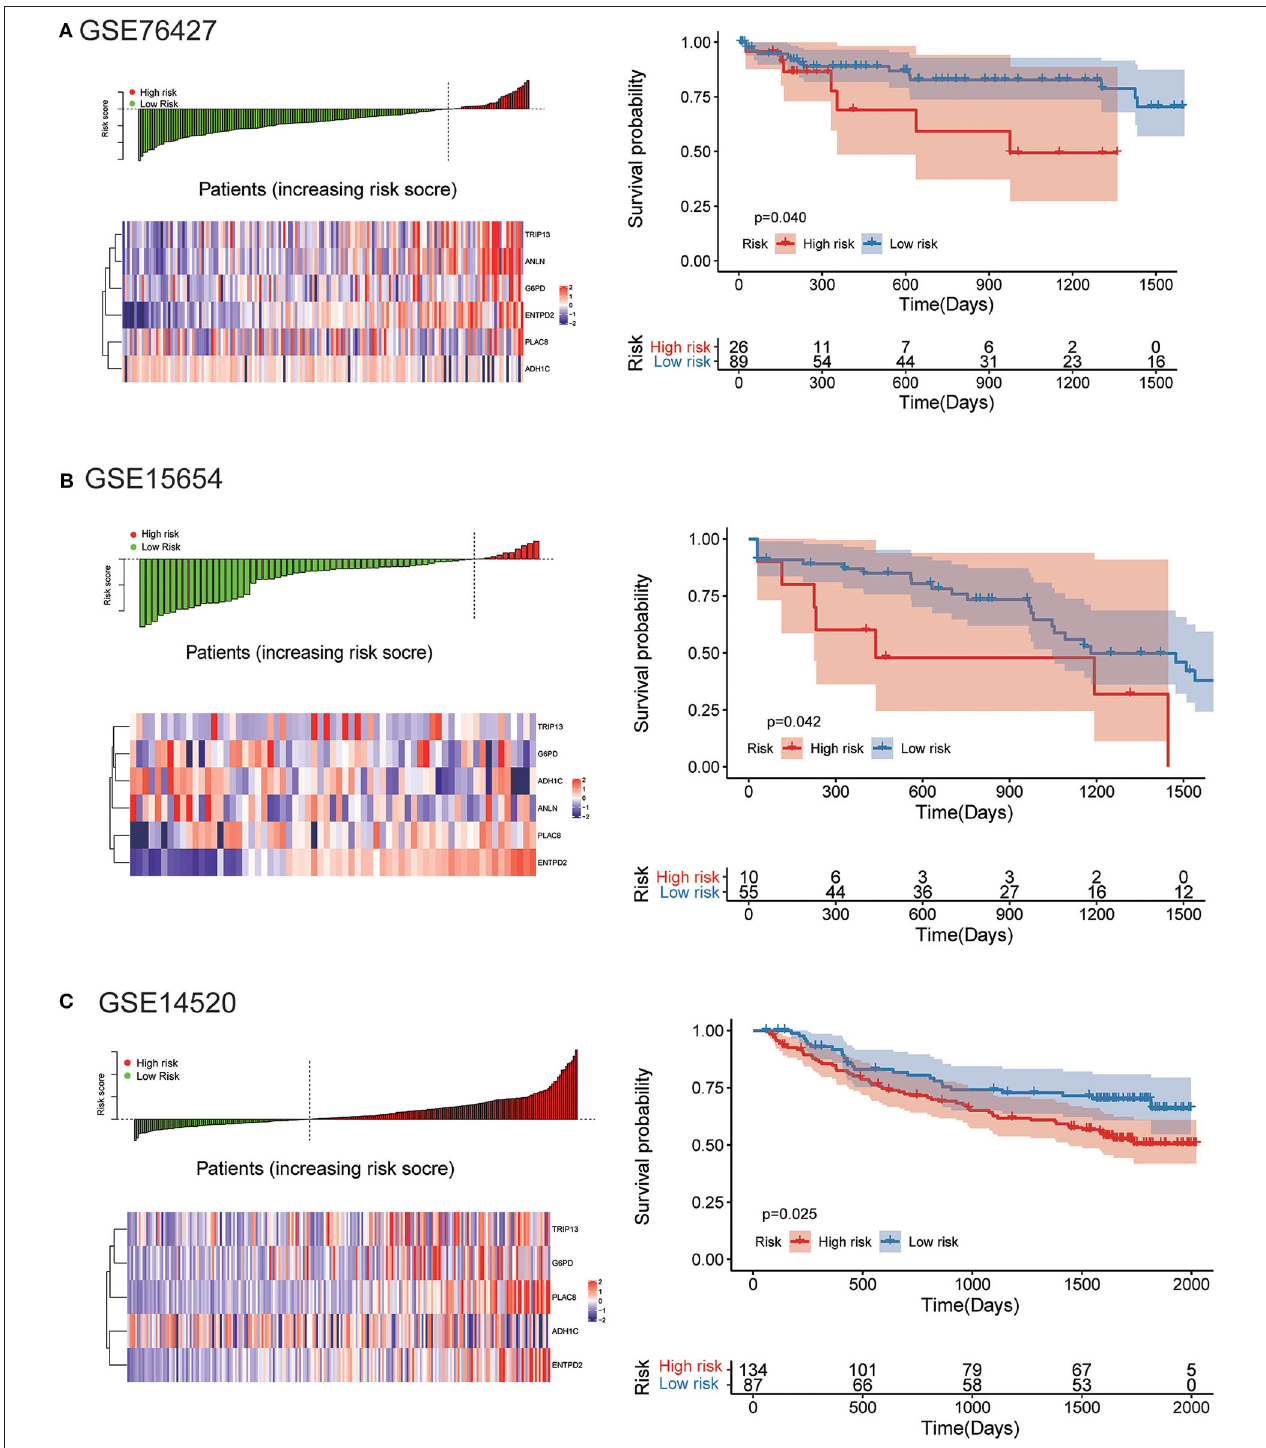
FIGURE 9 | External validation of the risk model in GSE76427, GSE15654, and GSE14520 datasets. (A) The distribution of risk score, six genes expression heat map, and the KM curves of the OS in the GSE76427 validation cohort. According to the risk score, the patients were divided into the high-risk group and low-risk group in the GSE76427 dataset; (B) The distribution of risk score, six genes expression heat map, and the KM curves of the OS in the GSE15654 validation cohort. According to the risk score, the patients were divided into the high-risk group and low-risk group in the GSE15654 dataset; (C) The distribution of risk score, six genes expression heat map, and the KM curves of the OS in the GSE14520 validation cohort. According to the risk score, the patients were divided into the high-risk group and low-risk group in the GSE14520 dataset.